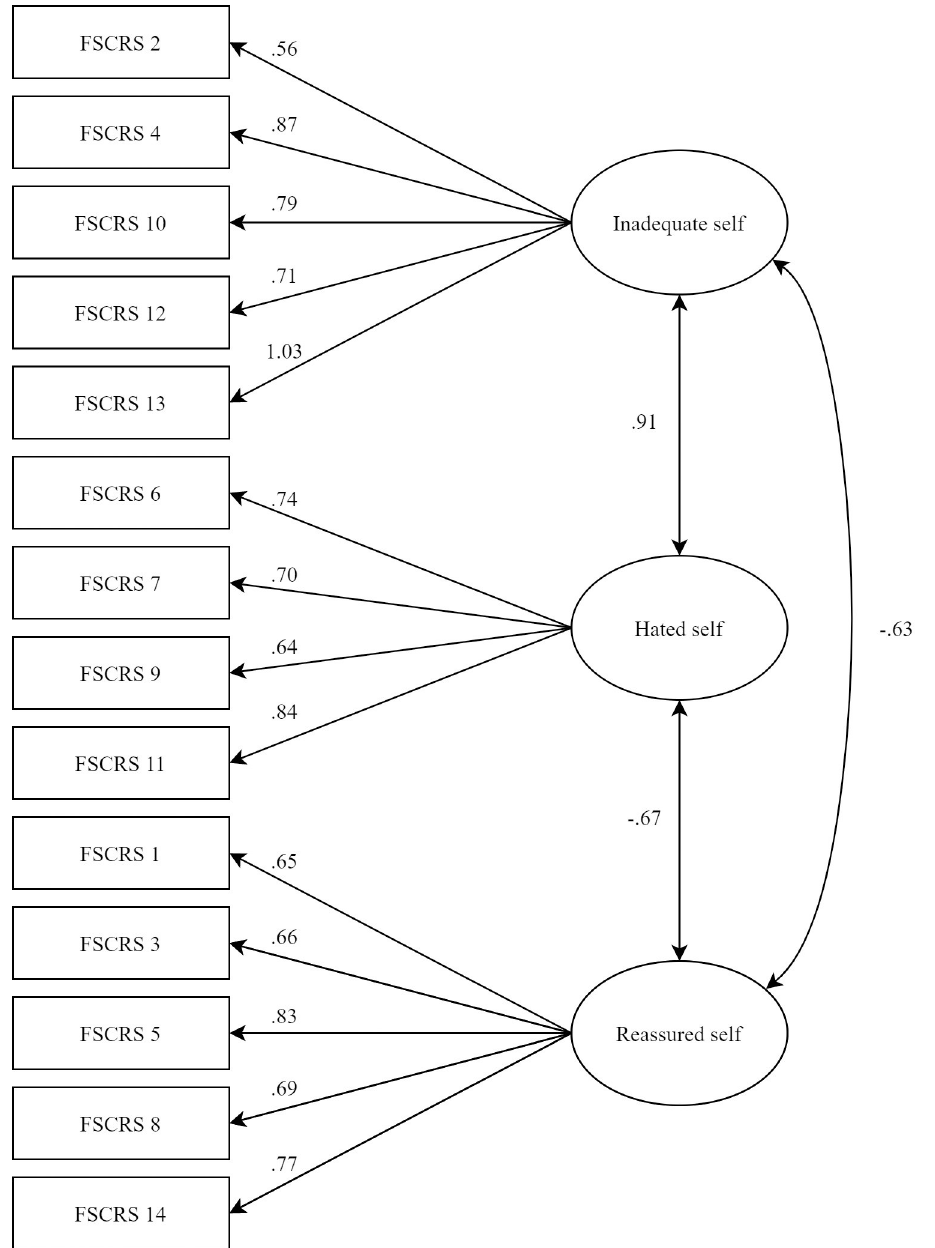
Fig 1. Confirmatory factor analysis model of the Forms of Self-Criticizing/Attacking and Self-Reassuring Scale- Short Form.